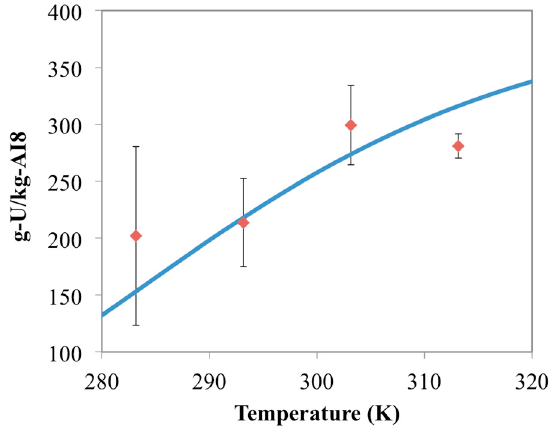
Figure 9. Comparison between chemisorption model results (blue line) and the AI8 experimental data (red diamonds) collected in this study. Error bars represent two standard deviations of the data.